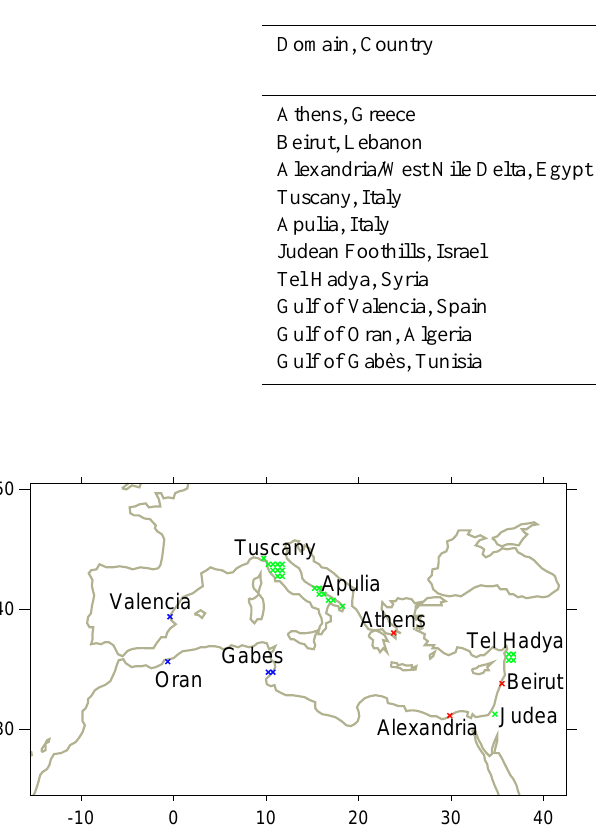
Table 1. Case-study domains (see also Fig. 1).